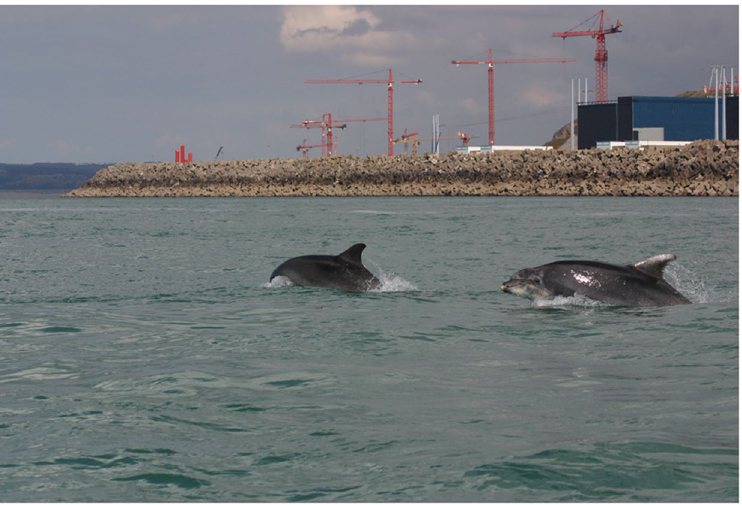
Figure 1. The bottlenose dolphin Tursiops truncatus in the Normanno-Breton Gulf (English Channel). Photo Credit: